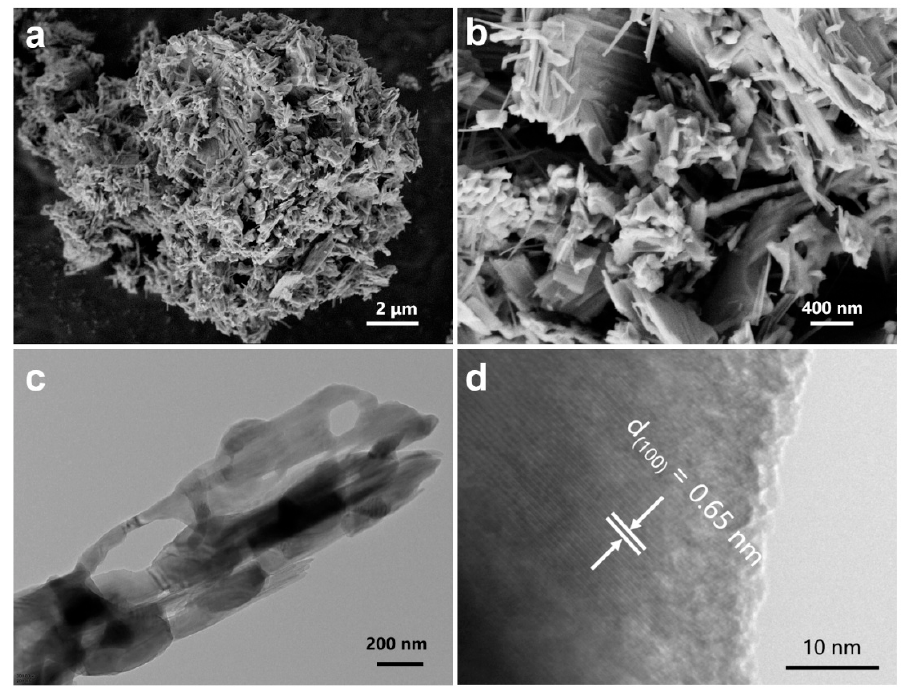
Figure 2. ( a , b ) SEM, ( c ) TEM, and ( d ) HRTEM images of LiV 3 O 8 .